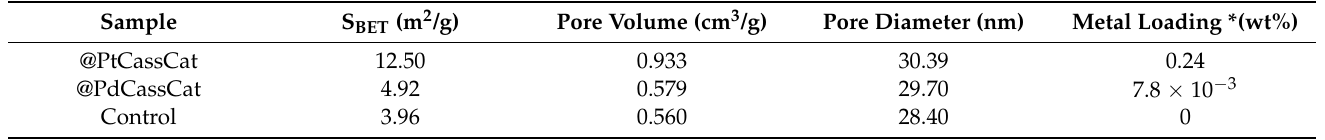
Table 4. Physicochemical characteristics of @PtCassCat, @PdCassCat, and control biochar